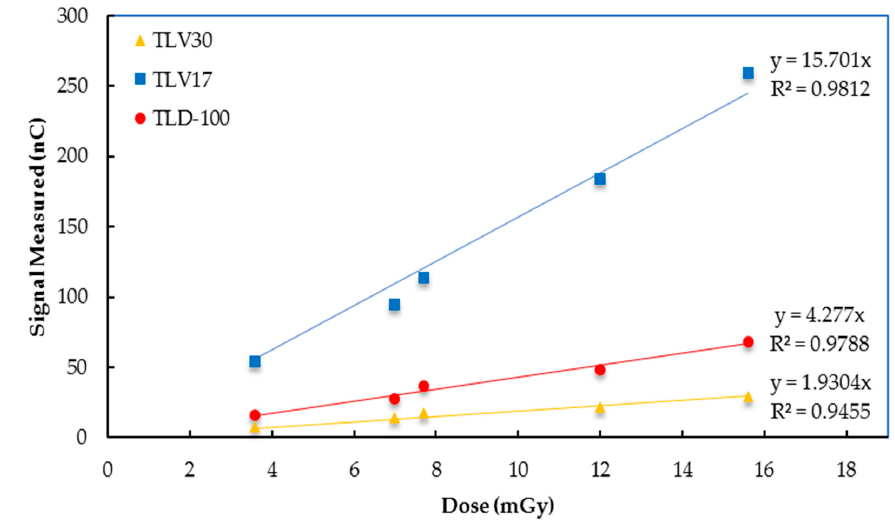
Figure 10. TLV17, TLV30 and TLD-100 CT radition dose–response linearity results.